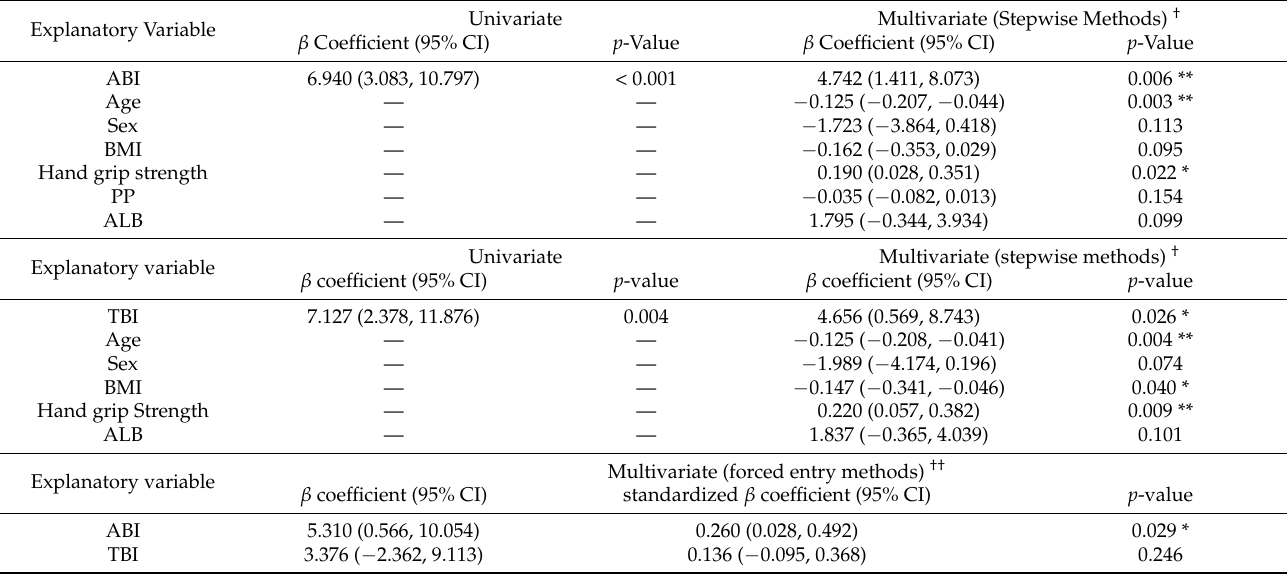
Table 3. Estimation of MoCA-J score and ABI/TBI values association in uni- and multivariate linear regression